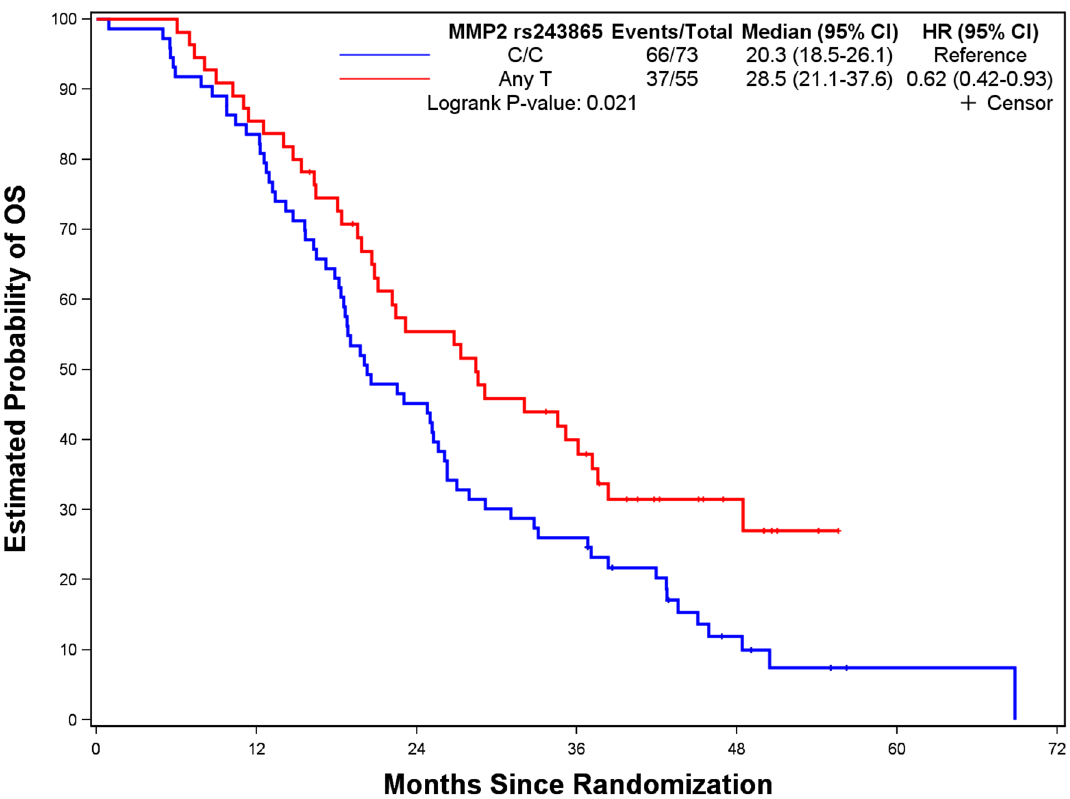
Figure 9. Kaplan–Meier curve and log-rank test for tumor budding pathway SNP predictive of OS in KRAS wild-type mCRC patients. Patients with MMP2 rs243865 Any T carriers have longer OS (28.5 vs. 20.3 mo; p = 0.021) compared to C/C